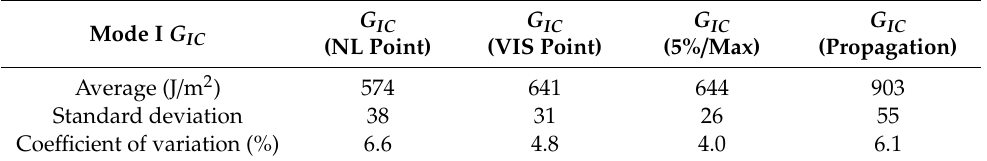
Table 1. Mode I fracture toughness values for UD FFREC.